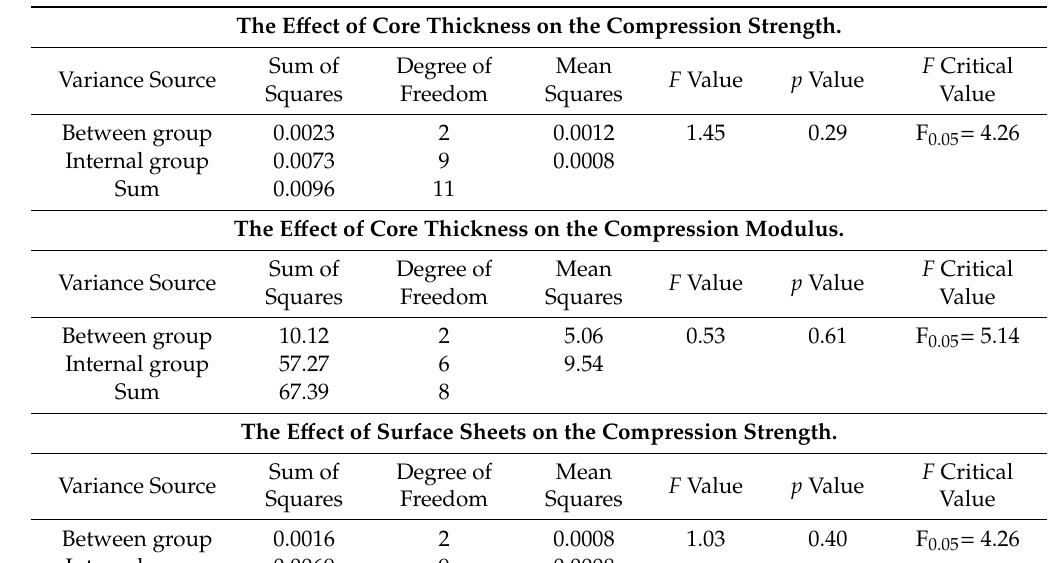
Table 6. Variance analysis